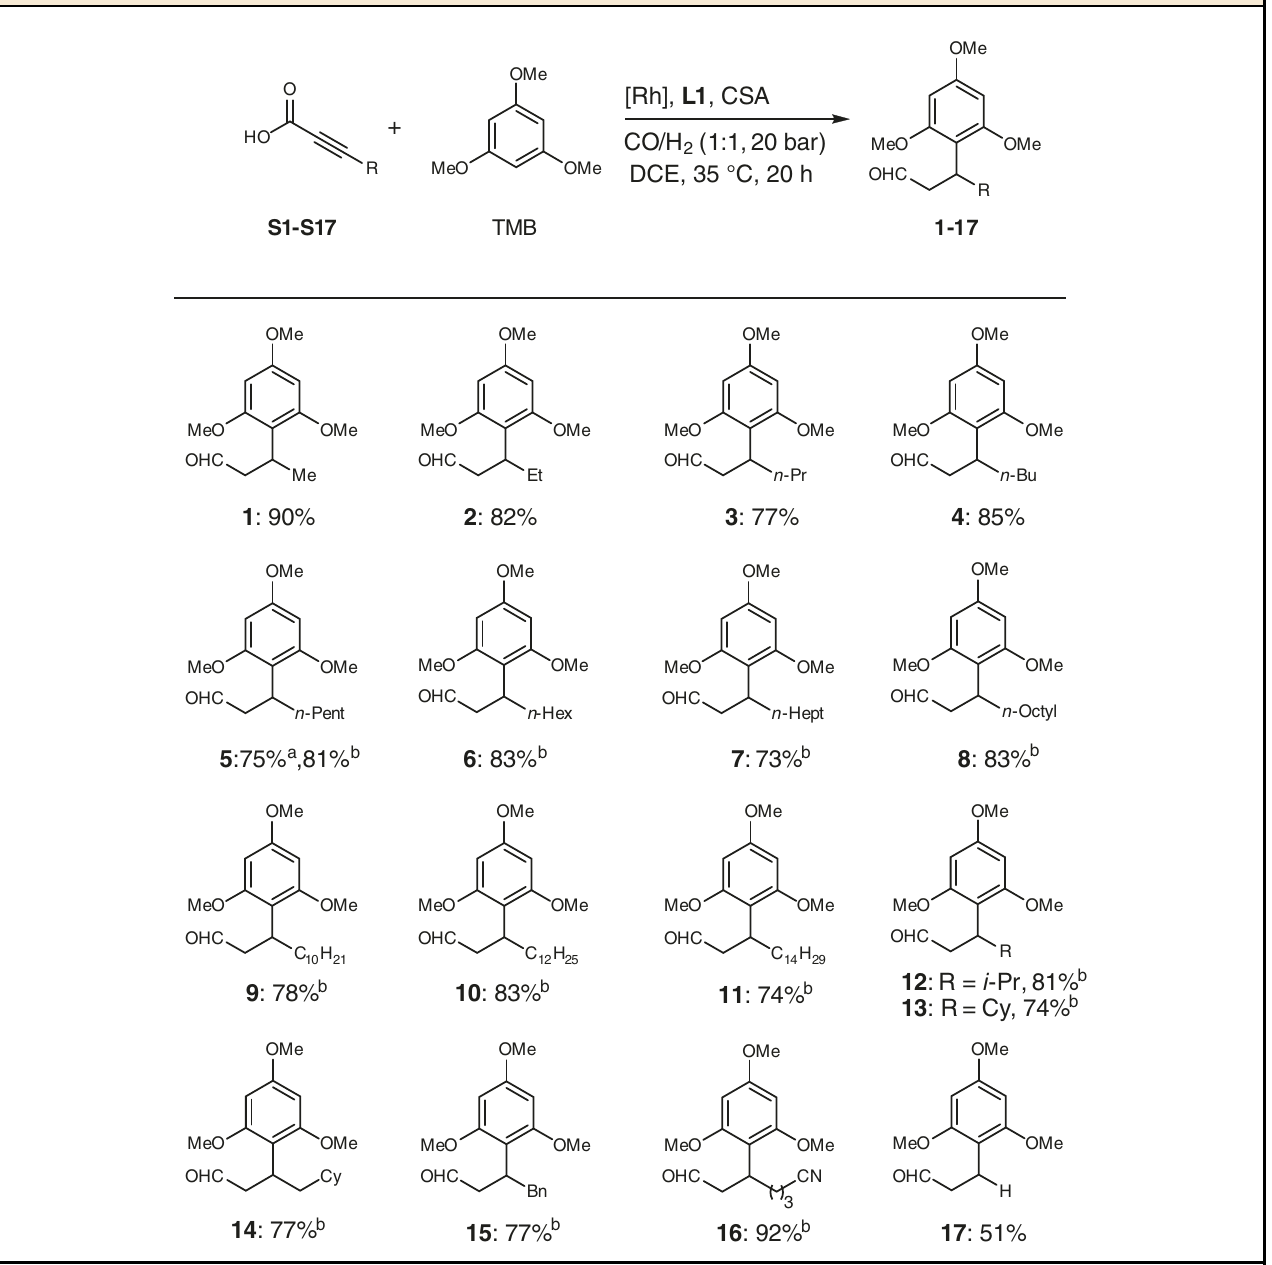
Table 2 Substrate scope of α -alkynoic acids with TMB